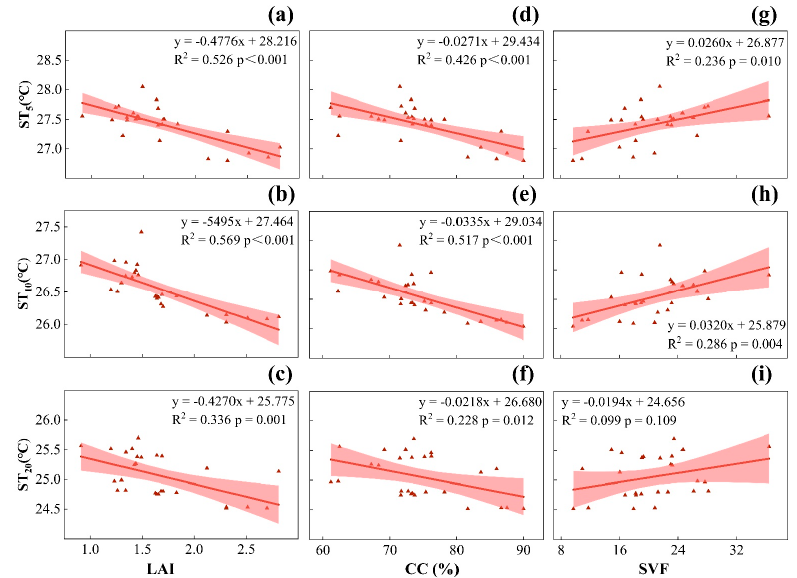
Figure 8. In summer, relationships between LAI in relation to different depths of ST at 5 cm ( a ), 10 cm ( b ), 20 cm ( c ); relationships between CC in relation to different depths of ST at 5 cm ( d ), 10 cm ( e ), 20 cm ( f ); relationships between SVF in relation to different depths of ST at 5 cm ( g ), 10 cm ( h ), 20 cm ( i ).